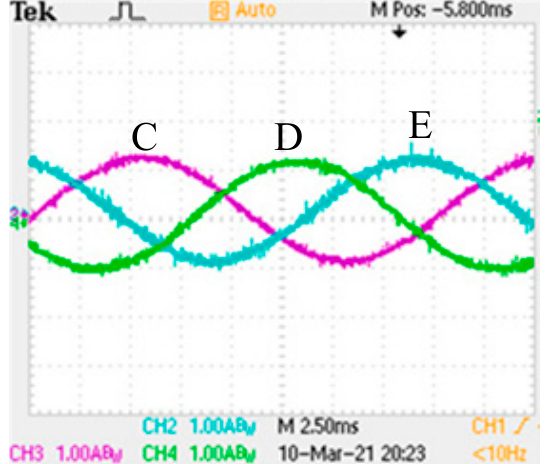
Figure 14. Lack of phase A and B fault − tolerant current waveform.